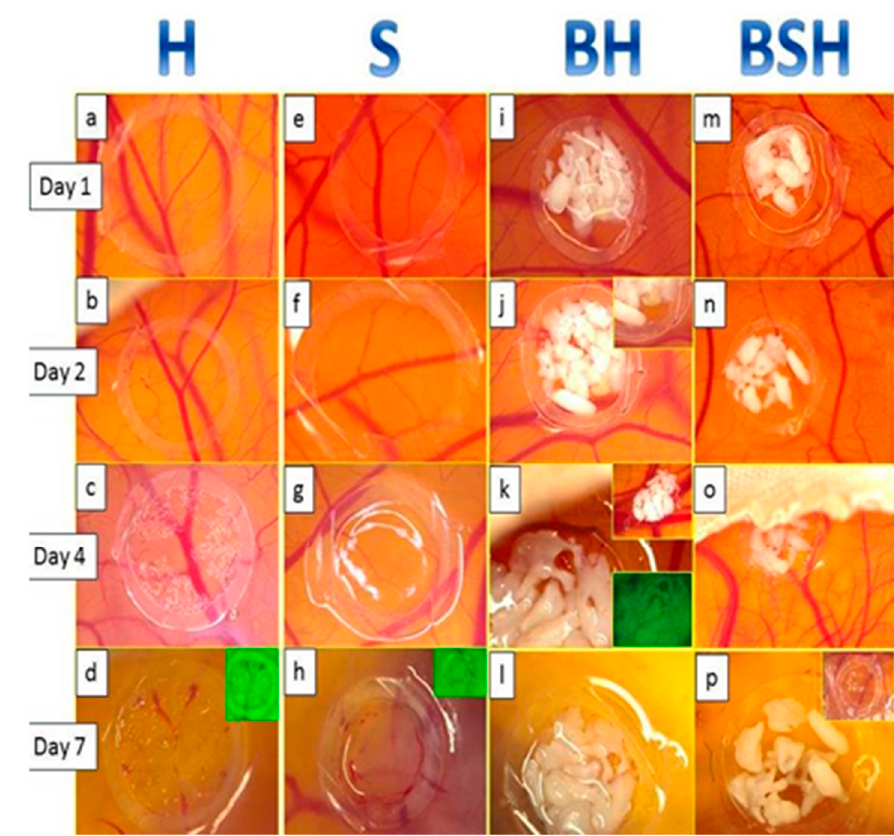
Figure 1. Stereomicroscopic view of CAM treated with hyaluronic acid (H), saline solution (S), bone substitute resuspended in H (BH), or in a mixture of S and H (BSH). A slightly vascular reaction was induced by H on day 1 and 2 ( a , b ), which was persistent until the end of the experiment ( c , d ). In contrast, S did not induce an increase in CAM blood vessel density ( e – h ). The BH complex applied on day 1 ( i ) dynamically changed its structure during the experiment. Small bone particles dispersed on H on day 2 ( j ) became structured in bigger bone lamellae on day 4 ( k ), and formed a compact mass by the end of the experiment ( l ). Compared with the BH complex, bone substitutes resuspended in a 1:1 mixture of H and S showed a less compact structure on CAM, with a restorative process starting from day 2 ( n ), and showing discohesive particles on day 4 and 7 ( o , p ). CAM biopsies harvested on day 13 were histopathologically and immunohistochemically